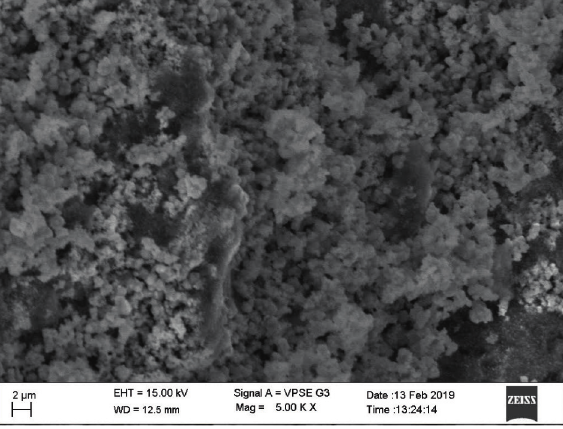
Figure 3: SEM image of a biosilica